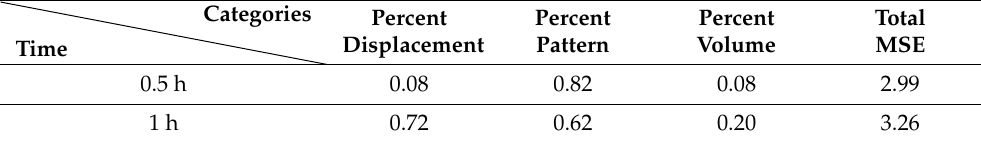
Table 4. CTREC algorithm extrapolation results’ CRA score.